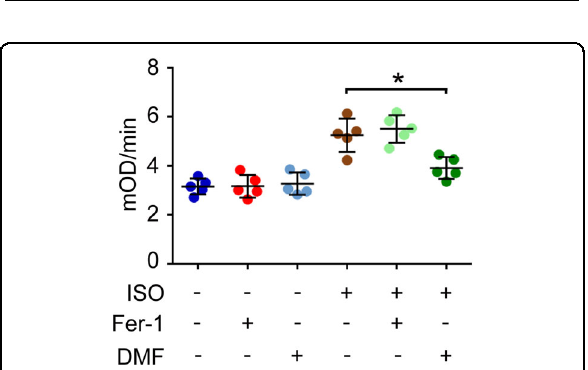
Fig. 5 Pre-treatment with DMF relieves the in fl uence of iso fl urane on the activity of cytochrome c oxidase/Complex IV in mitochondrial ETC. In the pre-treatment, 15 mg/kg DMF was administered (i.p.) 16 h before anesthesia, and 1 pmol of Fer-1 was injected into the striatum immediately before anesthesia. Then, the mice received iso fl urane exposure (ISO, 1.5%) for 6 h, and the hippocampus was isolated for the analysis. Herein, the activity of cytochrome c oxidase/Complex IV in mitochondrial ETC was evaluated in each group. * p value < 0.05 compared between two groups.